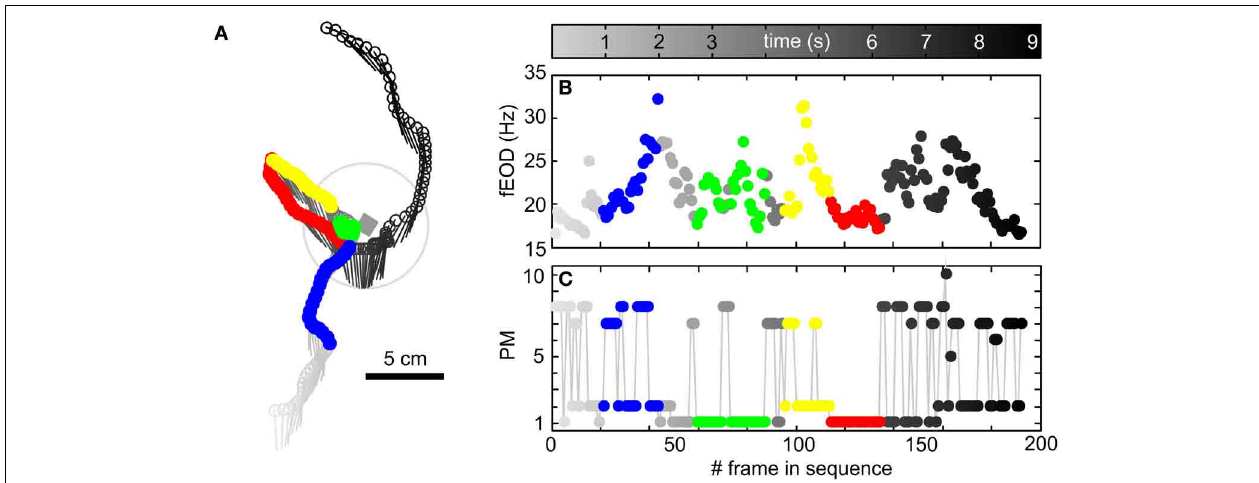
FIGURE 3 | Exemplary trajectory of an animal including quantitatively characterized behaviors, fEOD and the temporal structure of single-frames based PMs. (A) Head position (dots) and orientation (lines) of an animal during a segment (192 frames, 9.16s) of a video where a metal cube of 1cm side length (gray rectangle) was present in the arena. The temporal structure of the behavioral sequence is represented by the gray level of the symbols (see color bar above B ). The animal entered the view of the camera from south, approached the cube, stayed close to the cube and departed with a north-westerly heading. This was followed by a return to the object through backwards swimming, a bent around the object and then